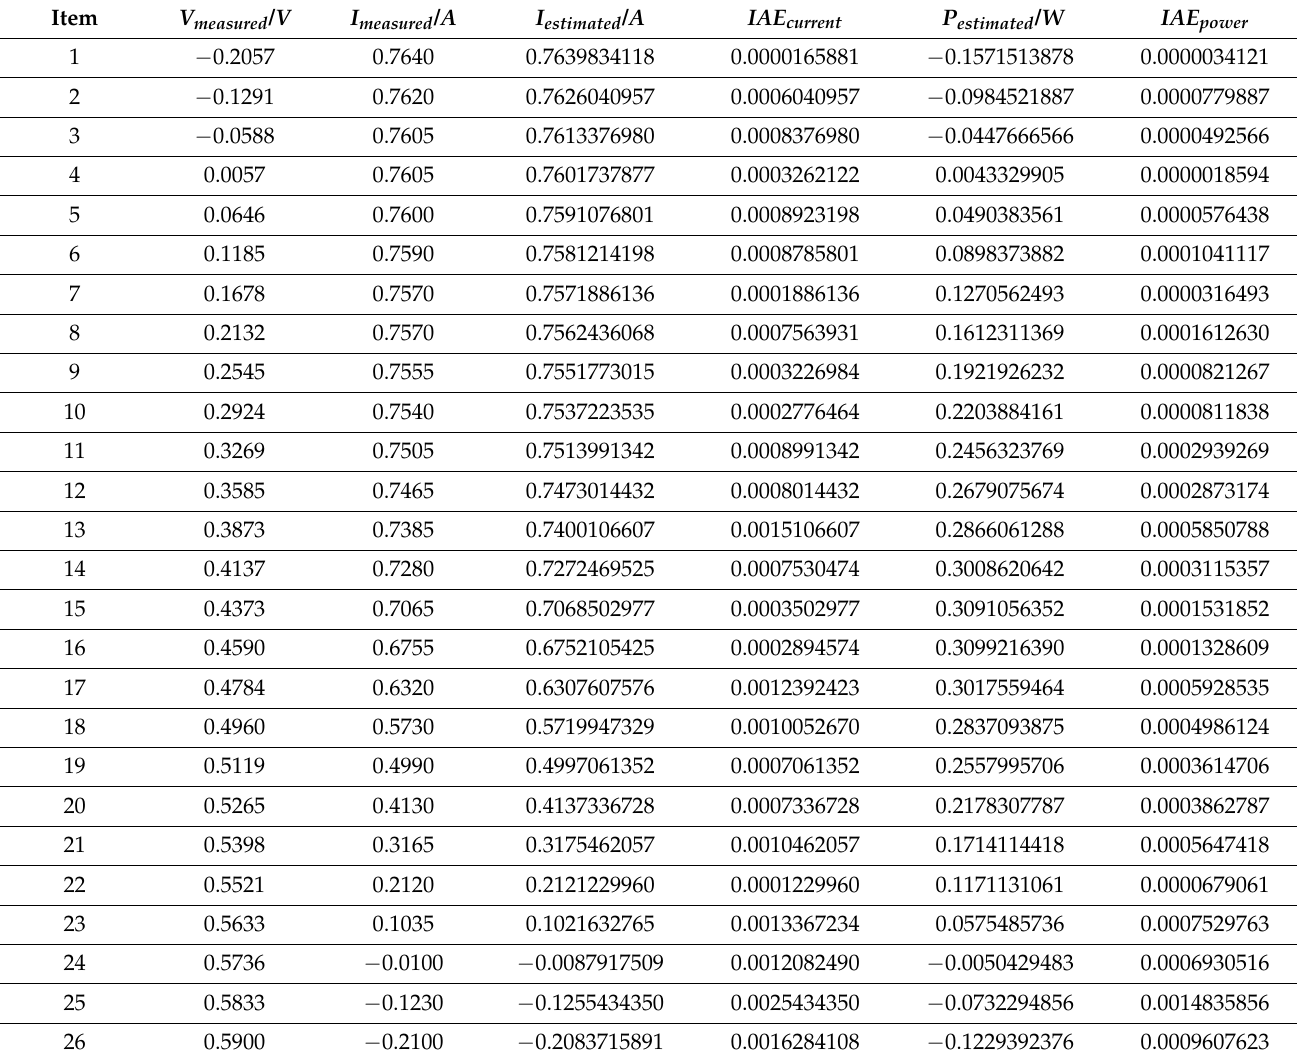
Table 8. IAE of CSOOJAYA for the DDM.